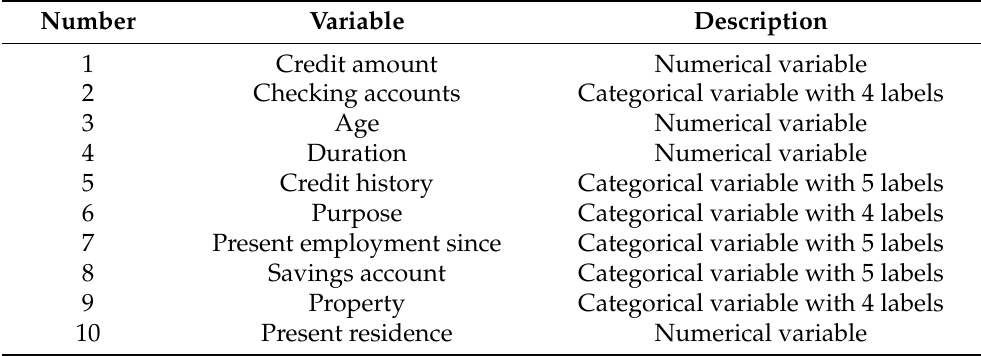
Table 5. The 10 most important predictors obtained via random forest recursive feature